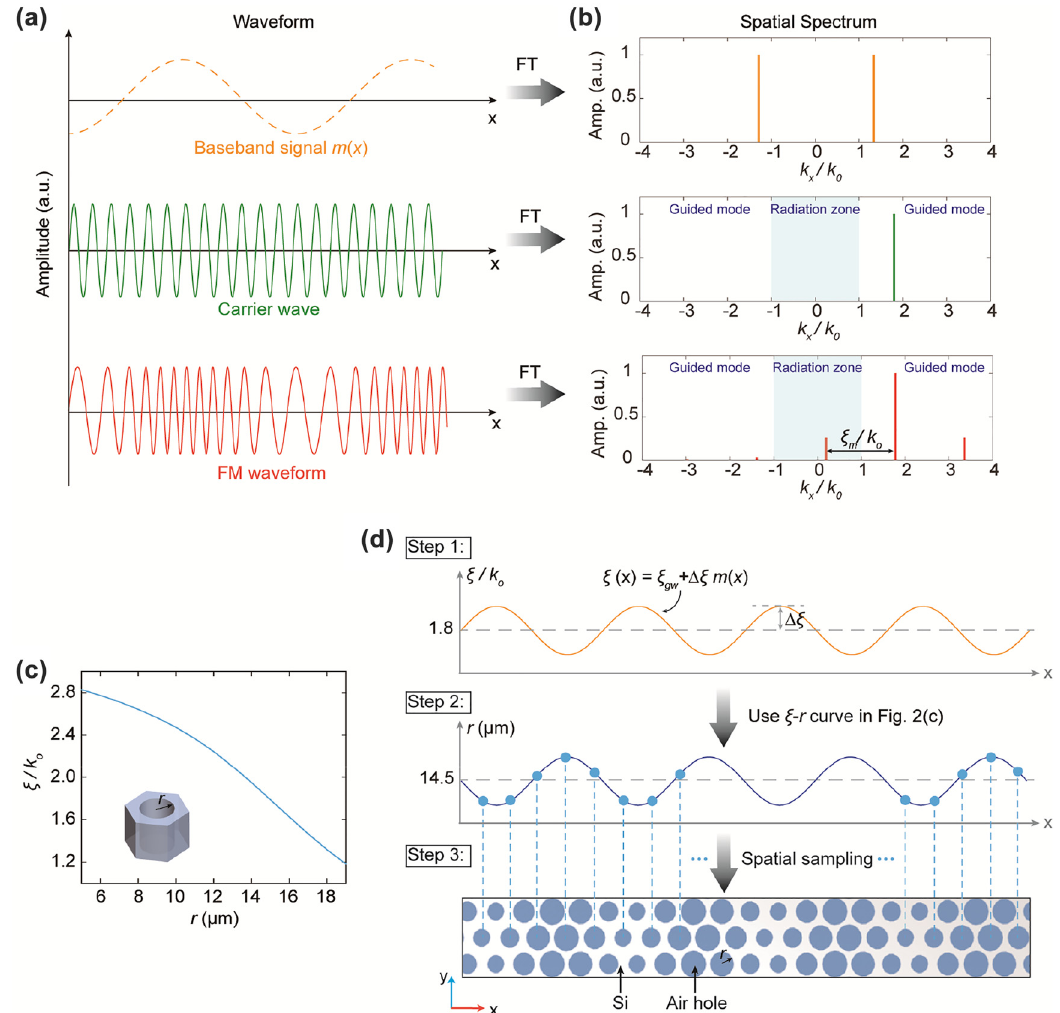
Figure 2: Working principle of the superheterodyne metasurfaces. (a) Waveforms of the baseband signal, carrier wave, and the modulated wave after the spatial frequency modulation. The carrier wave corresponds to the guided wave inside waveguides with uniform air holes. The dashed line of the baseband signal indicates it is fictitious, not representing any real waveform in the Si substrate. (b) The corresponding spatial spectra after performing spatial Fourier transform of the waveforms in (a). (c) Simulated local spatial frequency as a function of the radius of the air hole at 1 THz. Inset shows the configurations of the unit cell. (d). The detailed method of modulating the carrier wave. The radius of the air hole at each coordinate is selected to fulfill the required local spatial frequency pertinent to the baseband